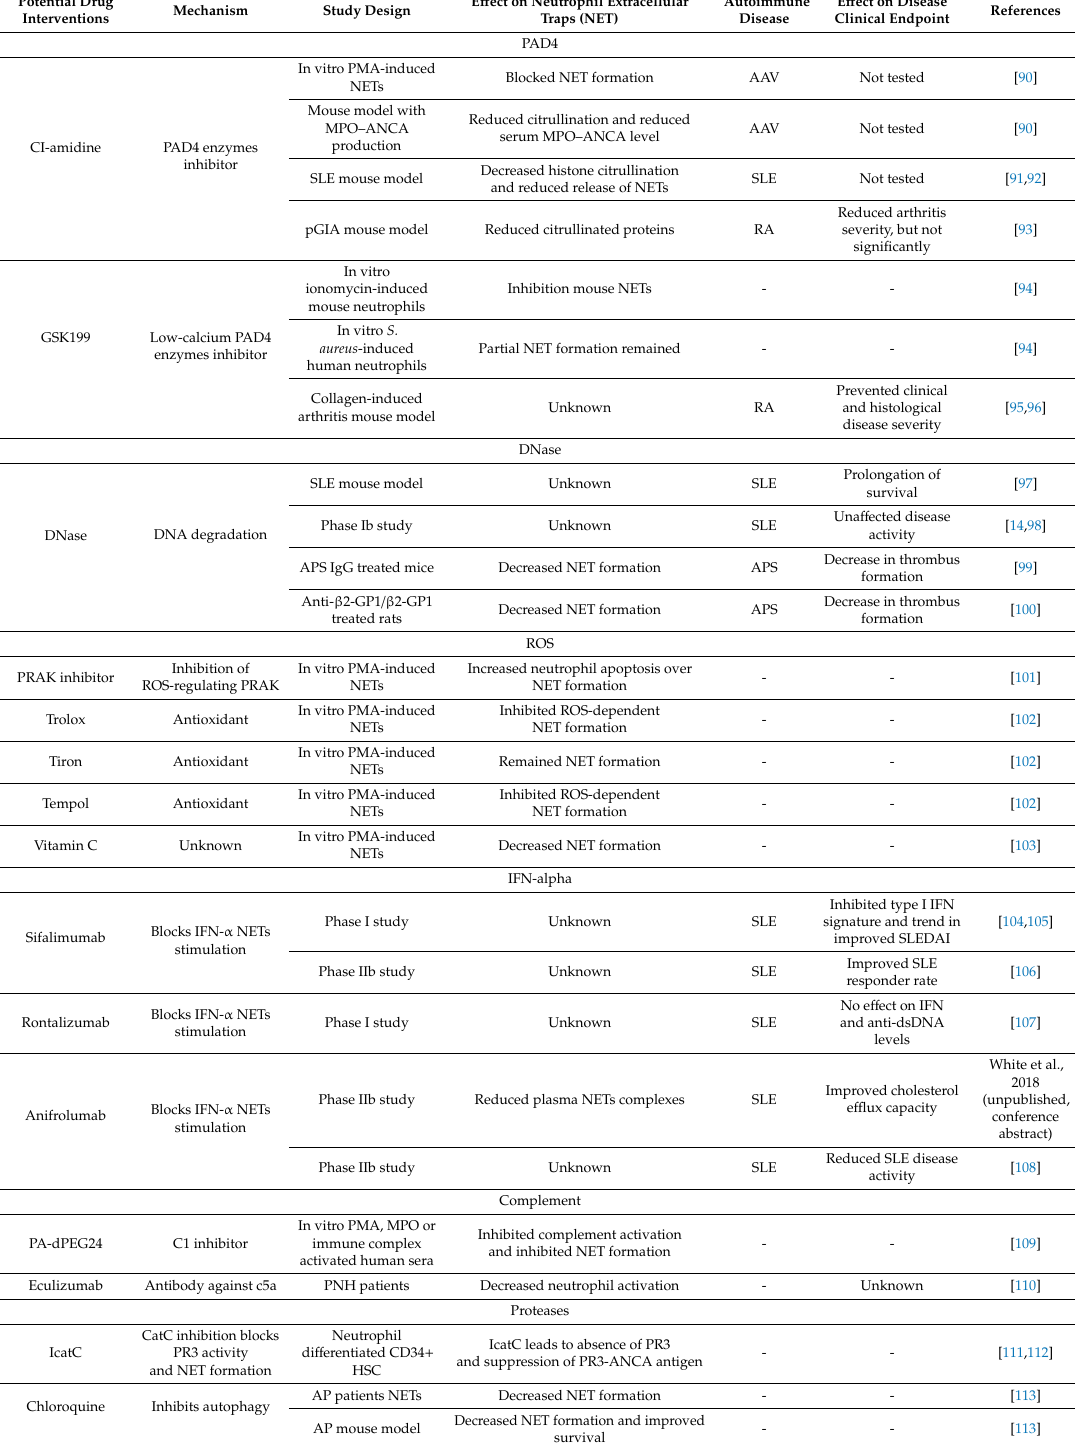
Table 2. Potential drug interventions targeting neutrophil extracellular traps (NETs) in autoimmune diseases (in vitro and in vivo